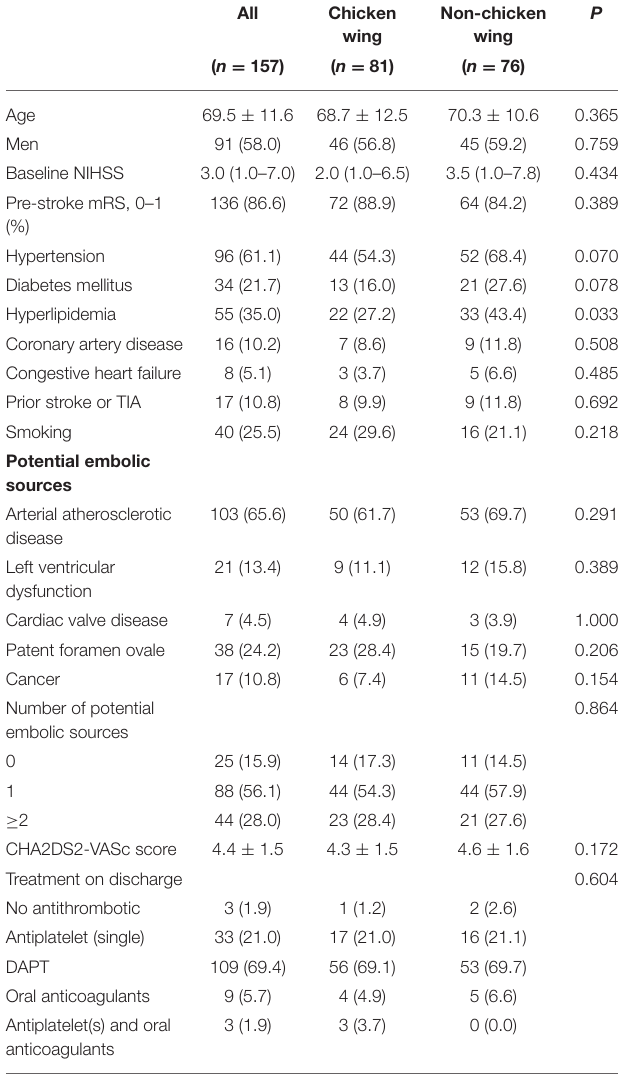
Variables are presented as mean ± standard deviation or absolute number (proportions). NIHSS, National Institute of Health Stroke Scale; mRS, modified Rankin Scale;